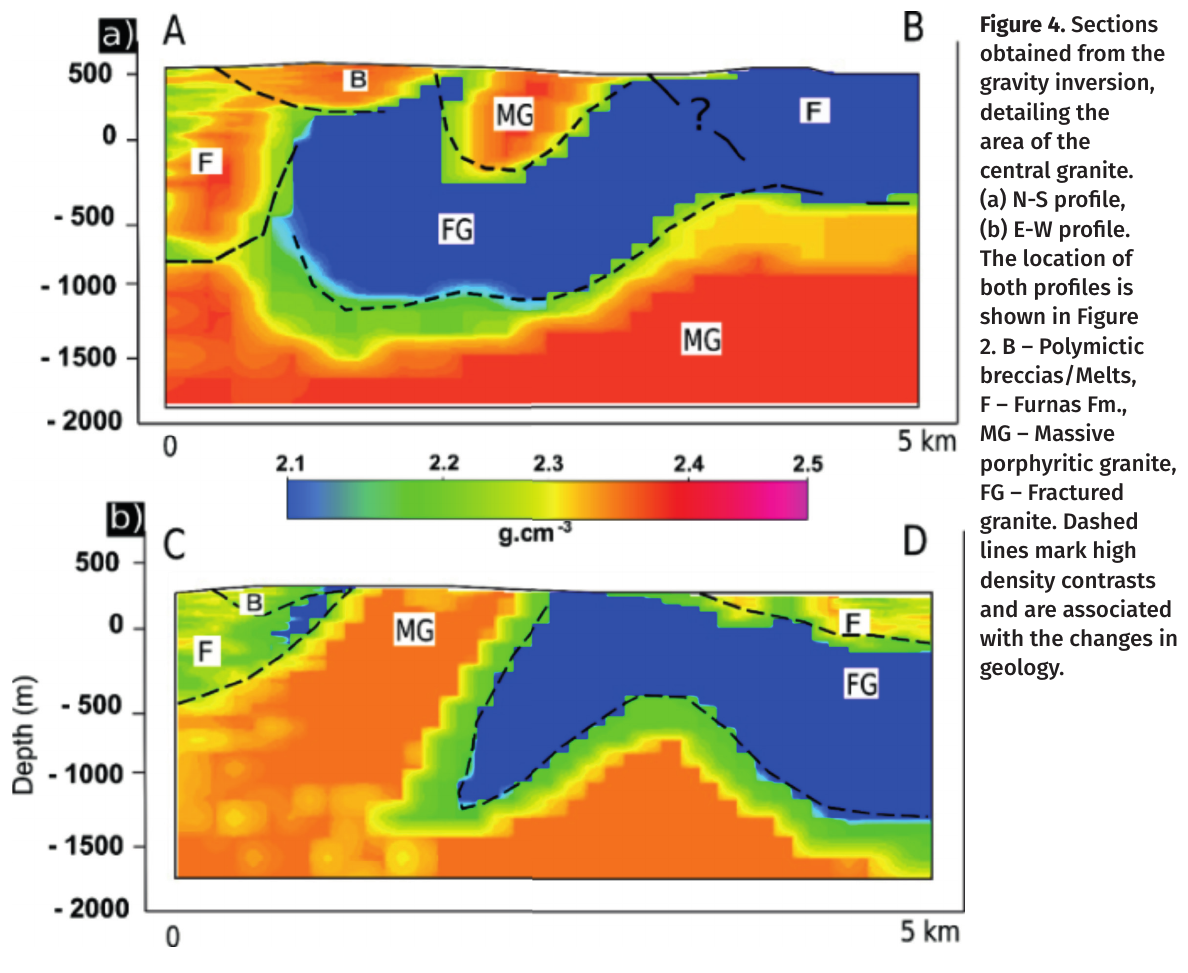
obtained from the gravity inversion, detailing the area of the central granite. (a) N-S profi le, (b) E-W profi le. The location of both profi les is shown in Figure 2. B – Polymictic breccias/Melts, F – Furnas Fm., MG – Massive porphyritic granite, FG – Fractured granite. Dashed lines mark high density contrasts and are associated with the changes in